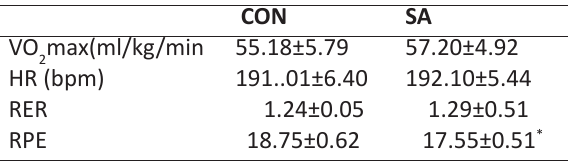
Table 2. Effects of repeated static apneas on VO